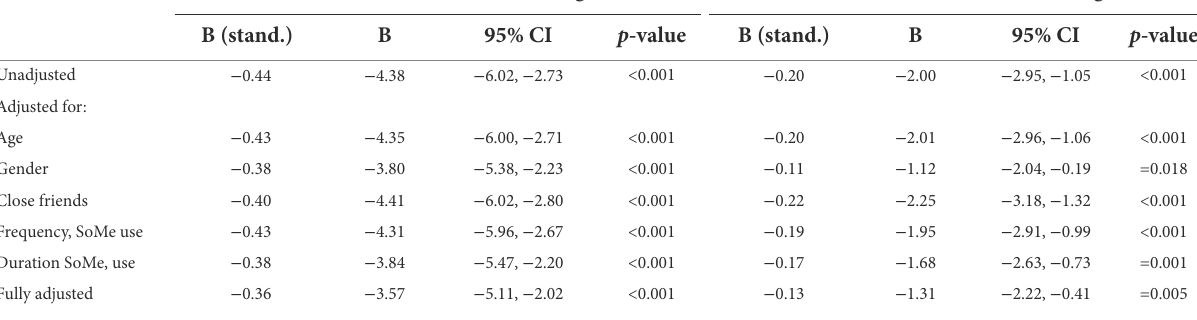
TABLE 3 Results from multiple regression analyses adjusting for covariates.